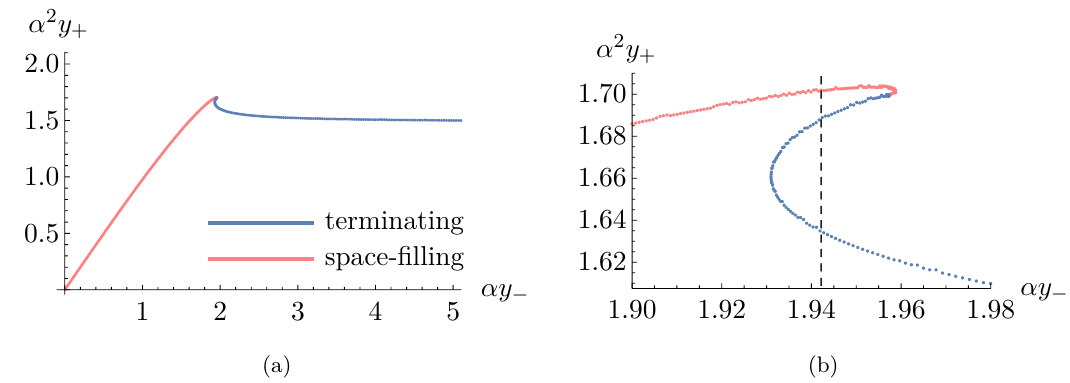
Figure 3. The normalizable mode y + , which is proportional to the vev, as a function of the non-normalizable mode y − , which is proportional to the source. The black vertical line shows the location of the quantum phase transition as determined from minimization of the free